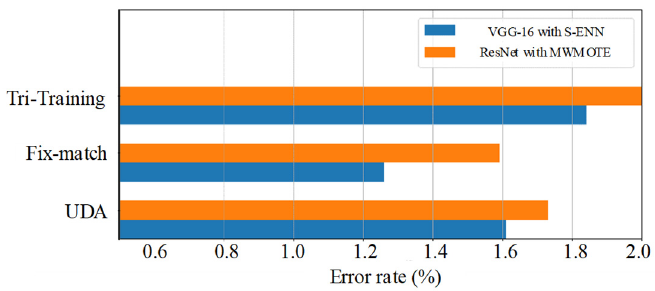
Figure 9. Error rates of different SSL models under different network structures.